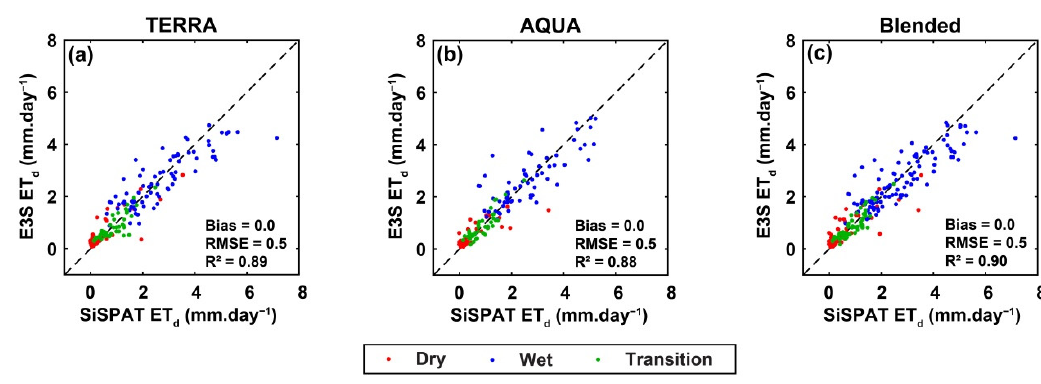
Figure 8. Daily ET d estimated by E3S from TERRA data ( a ), AQUA data ( b ), and combined TERRA/AQUA data ( c ) versus simulated by SiSPAT.